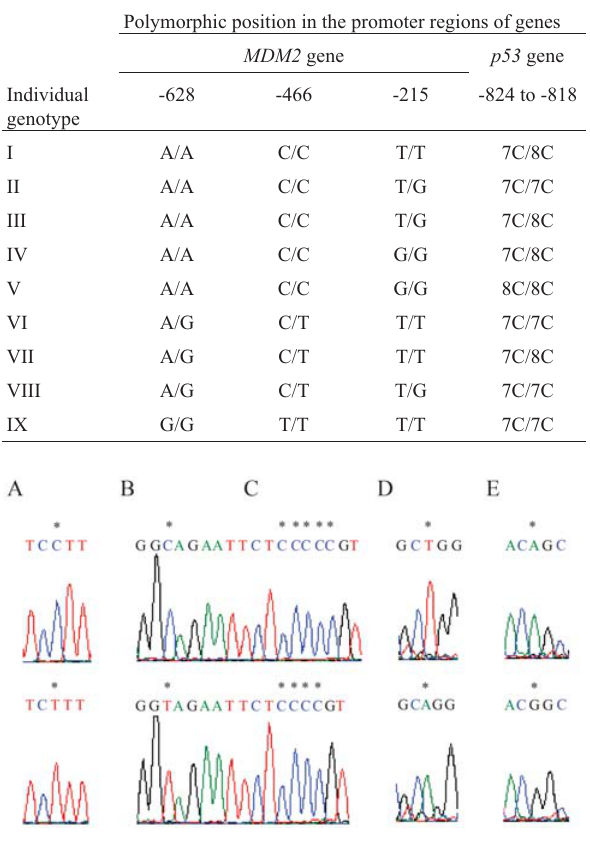
Figure 4 - Nucleotides in the vector constructs of p16 INK4a at positions -1602, -871, -862 to -858, -315, and -191. (A-E) Genomic DNA was am- plified by PCR with a forward primer at positions -1703 to -1683 and a re- verse primer at -93 to -113 of the p16 INK4a gene and then cloned into PGVB2 vectors. The nucleotides of the cloned sequences were examined using primers at positions -1706 to -1684, -950 to -931, -381 to -361, and -248 to -228. (*) shows nucleotides at positions -1602 (A), -871 (B), -862 to -858 (C), -315 (D), and -191 (E) of the p16 INK4a promoters. Nucleotides around these polymorphic positions (*) are